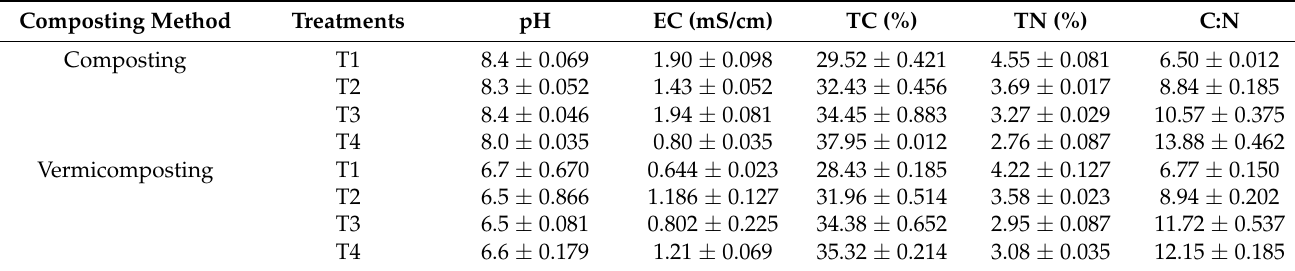
Table 3. Selected chemical properties of the end-product compost and